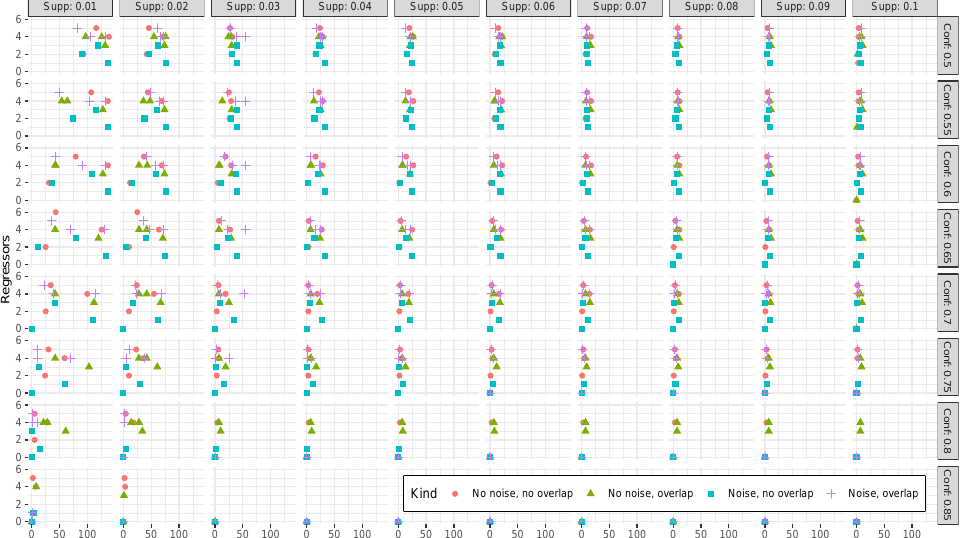
Figure 4. Rules and regressors for each experimental setting on all datasets. Results for confidence levels above 0.85 are removed as no rule is detected irrespective of the level of support.